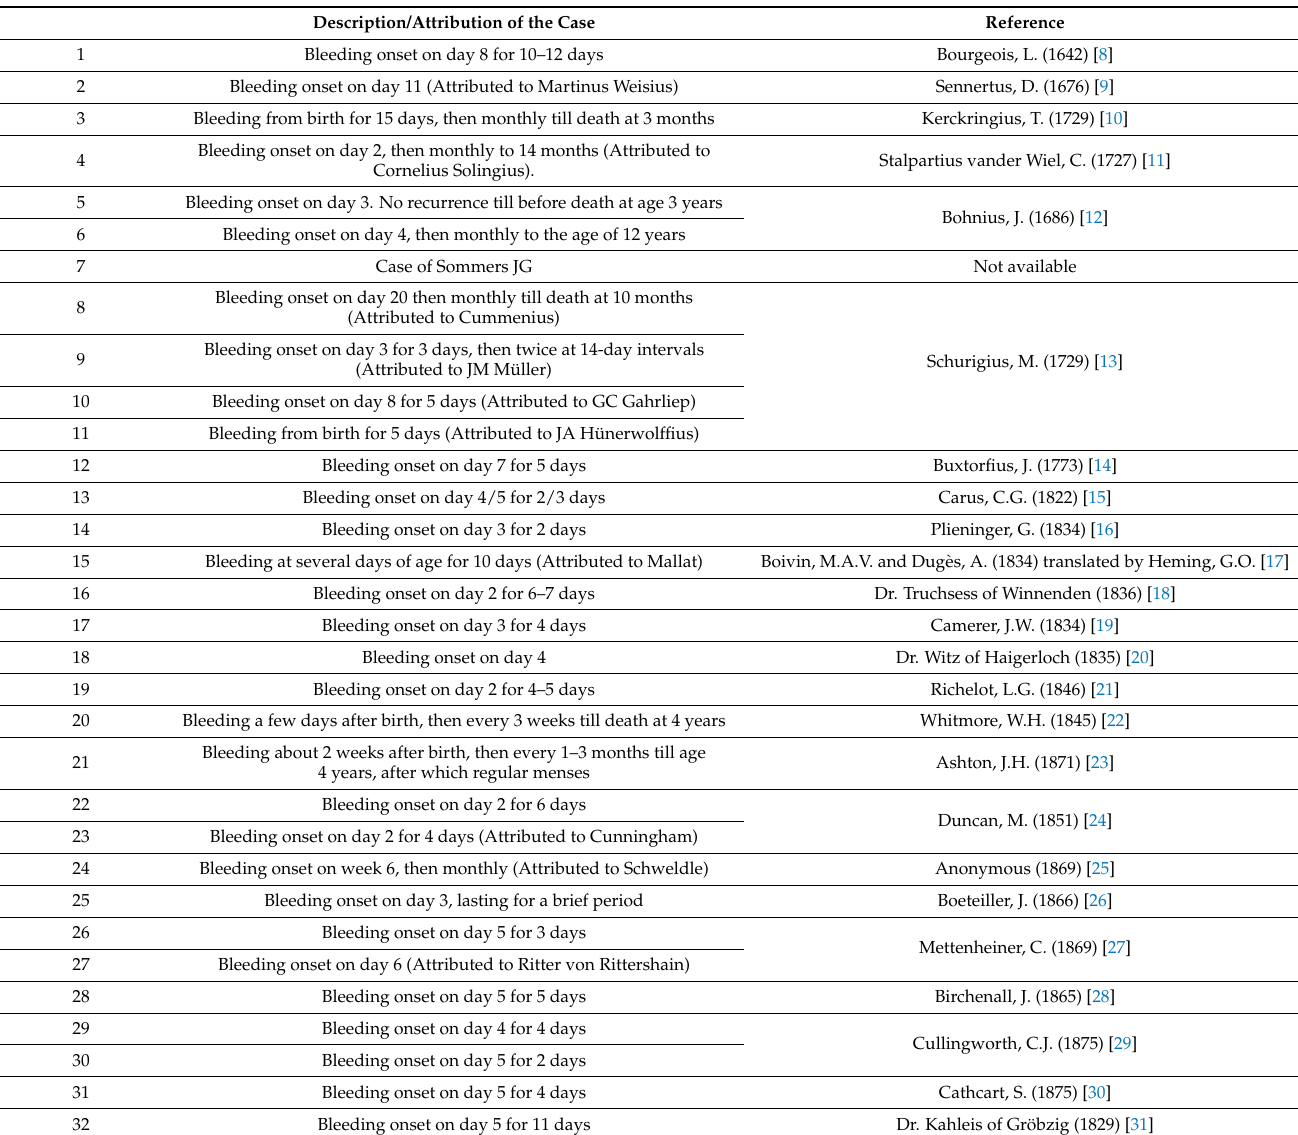
Table 1. Cases collated by Cullingworth [7] that contained a reference to bleeding in the neonatal period. One of the articles reported in the original table could not be